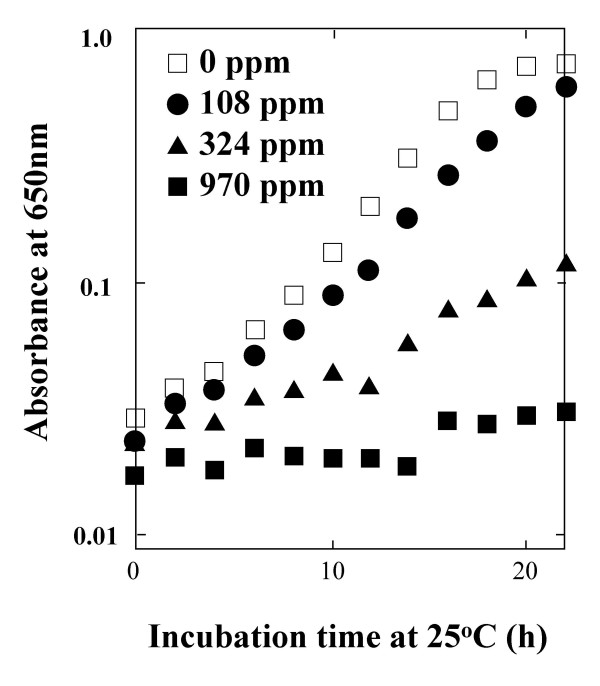
Effect of citrinin on yeast growth. Citrinin dissolved in DMSO at a concentration of 20000 ppm was added to the YPD medium to achieve the indicated concentration. The stock solution was added directly to the yeast cells grown for 2–3 days such that they were diluted more than 100-fold.